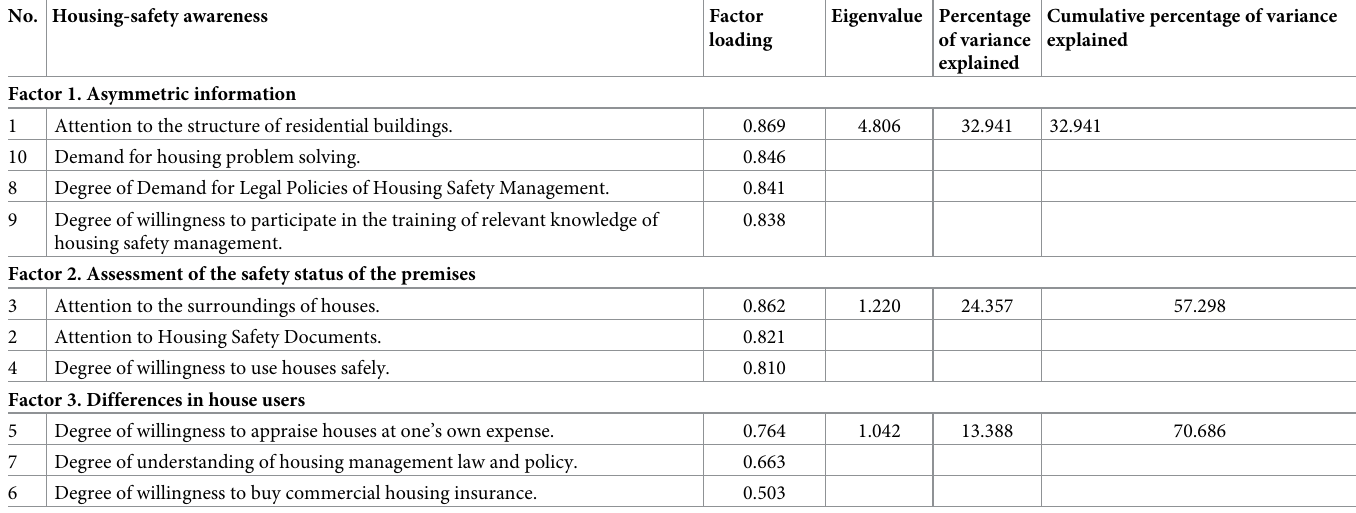
Table 7. Factor structure of principal factor extraction and promax rotation on the 10 housing safety awareness